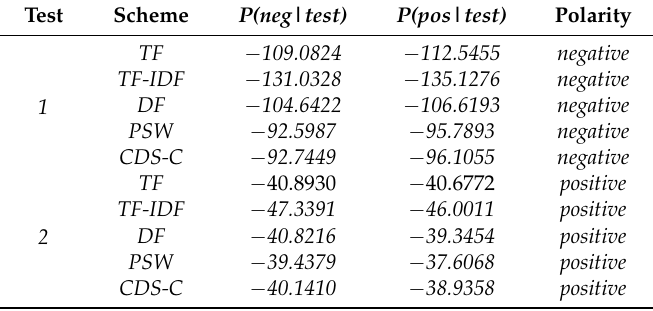
Table 4. The decisions of polarity based on the sentiment values. TF: Term Frequency, TF-IDF: Term Frequency and Inverse Document Frequency, DF: Document Frequency, PSW: Part-of-Speech feature-based Weighting, CDS-C: Category Discriminative Strength with Chi-Square